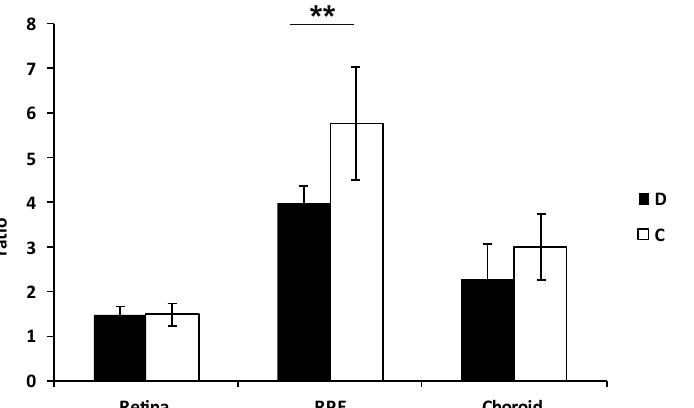
Figure 4. Total coenzyme Q10 content in the different layers of the minipig high intraocular pressure-induced retinal ischemia eyes. The total Q10 content in the tissue homogenate was determined using HPLC with UV detection at 275 nm. Values of Q10 content normalized to citrate synthase are shown. D—diseased eyes, C—controls. n = 3. Each sample was analyzed in doublets.** p < 0.001.